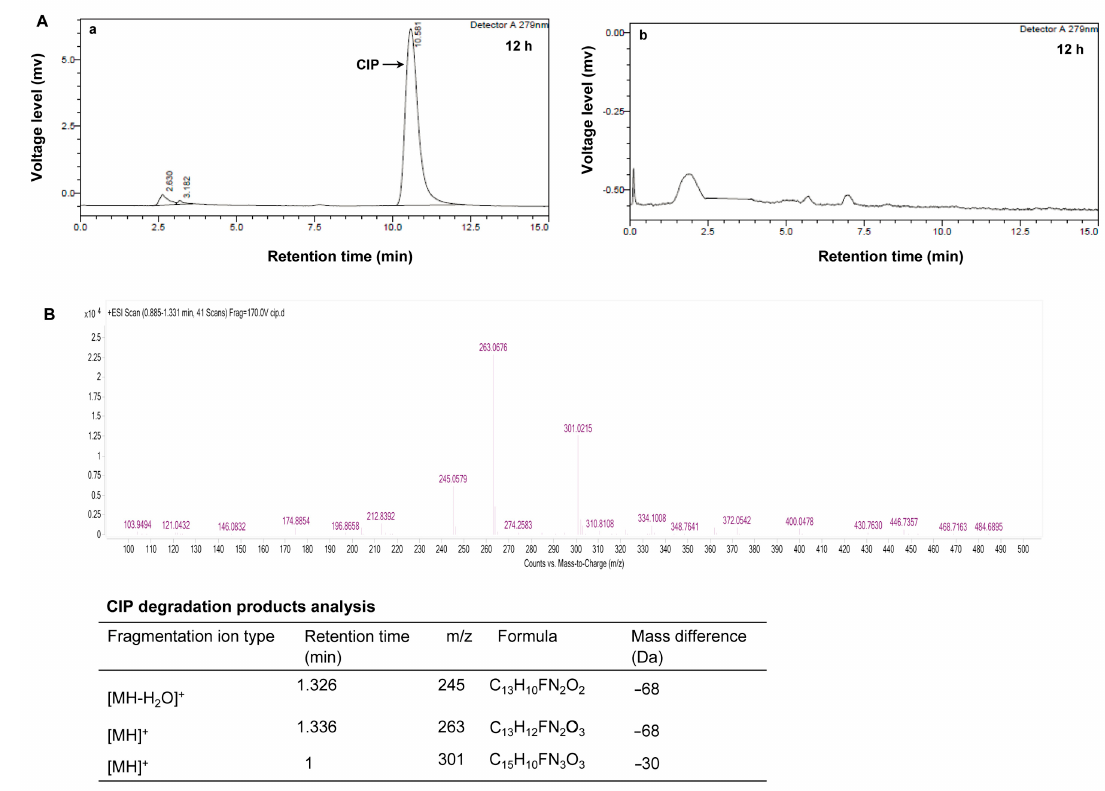
Figure 4. ( A ) HPLC chromatographs of CIP degraded by the BMO composites: ( a ) without the BMO composites; ( b ) with the BMO composites for 12 h. ( B ) LC/MS assays of the CIP-degraded intermediates.